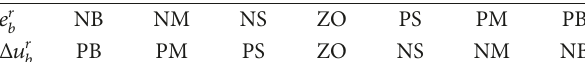
Figure 3: The degree of membership of fuzzy set Di. Table 1: Fuzzy control rules